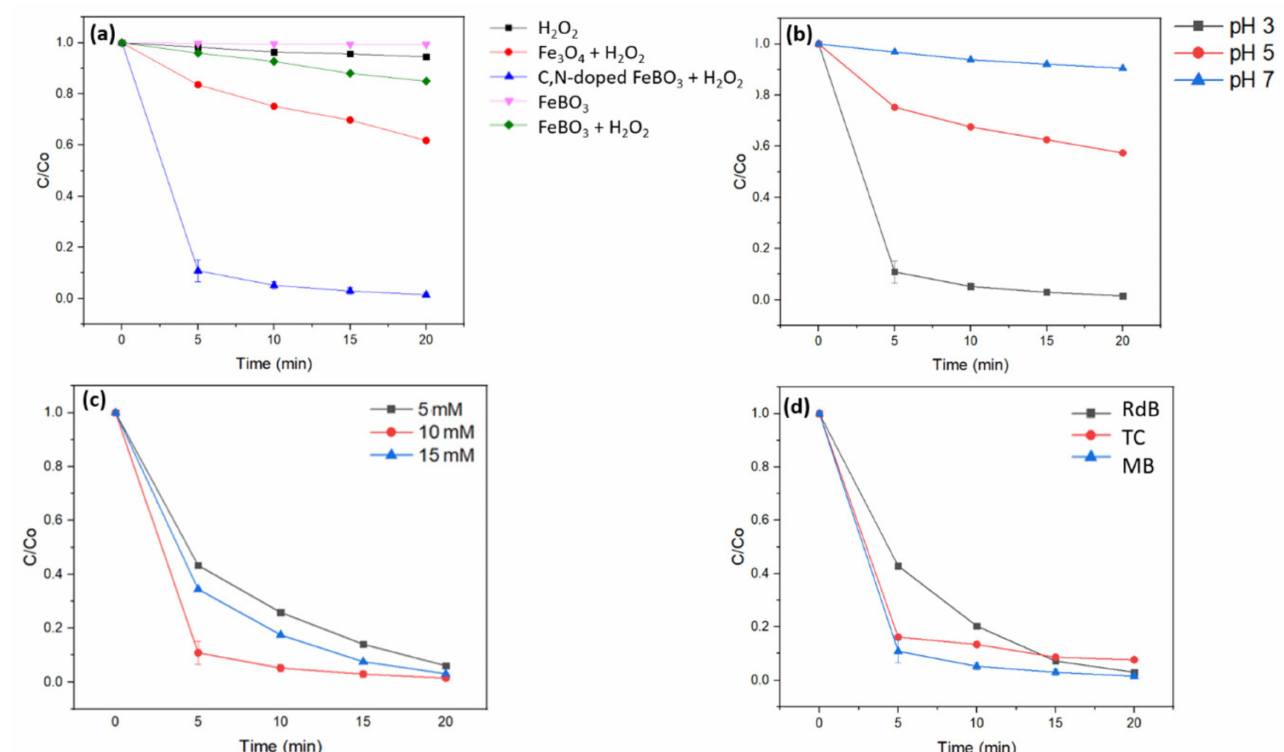
Figure 6. The MB degradation curves under simulated A.M 1.5 solar illumination for ( a ) the 5 wt.% photo-Fenton catalysts in the presence and absence of H 2 O 2 , ( b ) the 5 wt.% C,N-doped FeBO 3 and H 2 O 2 at various pH values, ( c ) the 5 wt.% C,N-doped FeBO 3 and H 2 O 2 at various H 2 O 2 concentrations, and ( d ) the photo-Fenton degradation activities for different pollutants using the 5 wt.% C,N-doped iron borate catalyst (pH = 3, H 2 O 2 concentration = 10 mM, pollutant concentration = 10